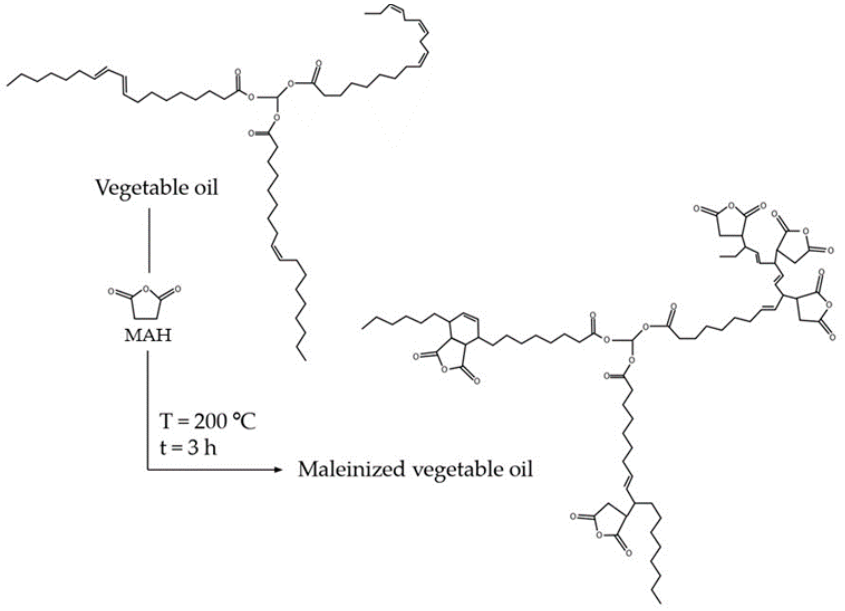
Figure 1. Schematic representation of the maleinization process of the triglyceride presents in vegetable oil.